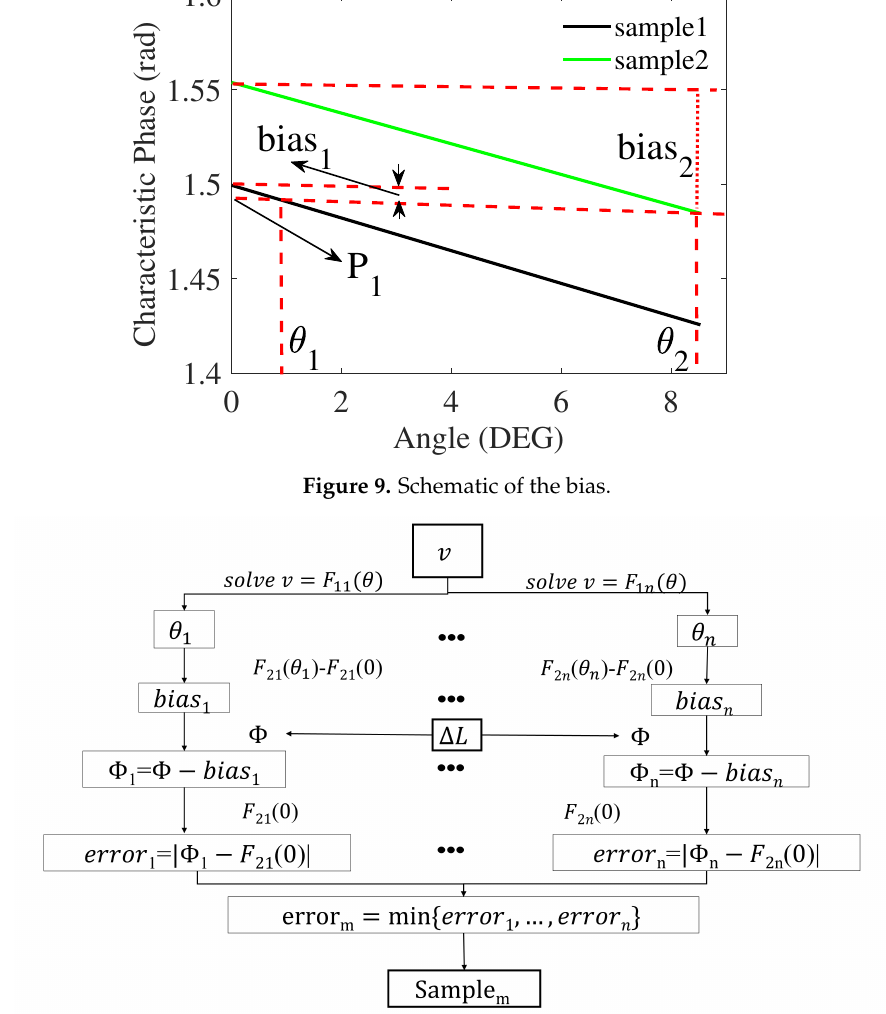
Figure 10. The flow diagram of the